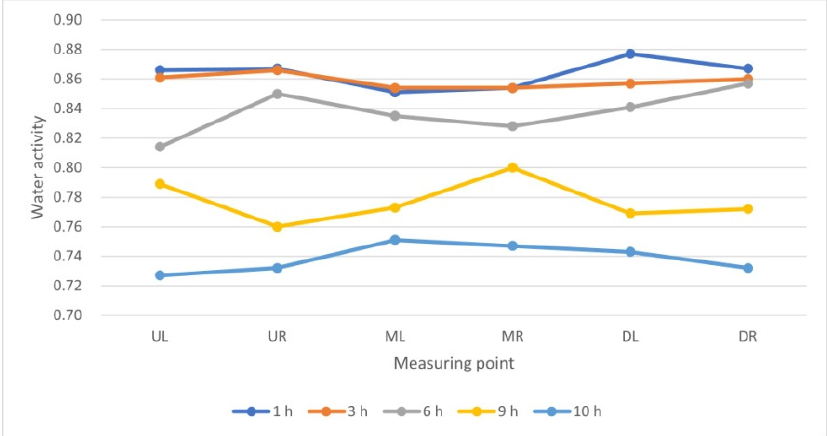
Figure 19. Comparison of changes in water activity (Wa) of beef samples in chamber 5 depending on